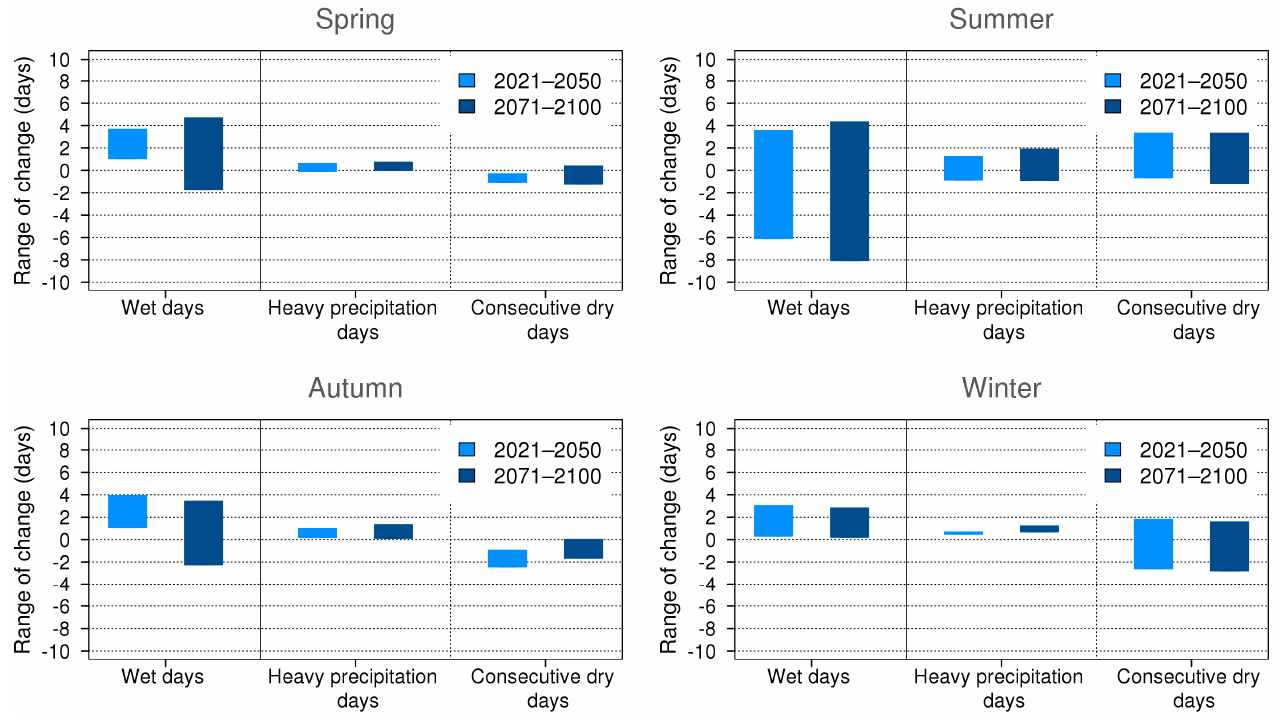
Figure 23. Range between the minimum and maximum changes (in days) in the seasonal mean number of wet days, heavy precipitation days and consecutive dry days over Hungary for 2021–2050 and 2071–2100, based on four RCM simulations. Reference period: